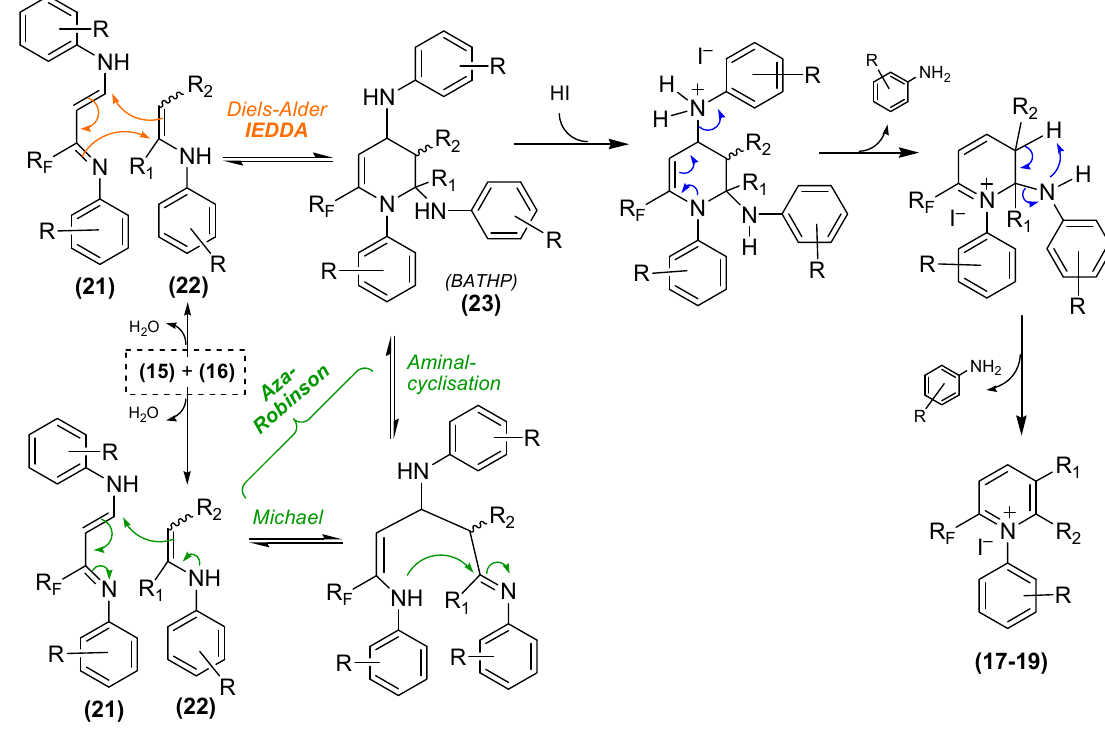
Scheme 7. Diels-Alder/Aza-Robinson bis-de-anilino-elimination cascade mechanism hypotheses of formation 2-trifluoromethyl and 2-perfluoroalkyl- N -arylpyridiniums 17 – 19 . BATHP: bis-anilino-